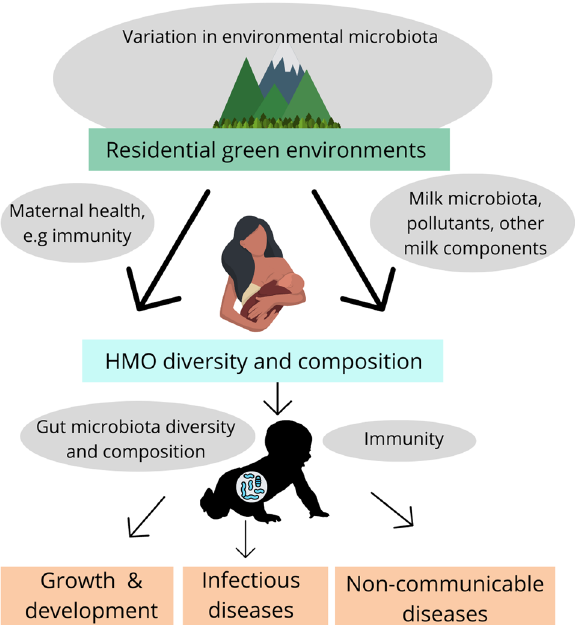
Figure 2. Potential pathways from residential green environment to infant health via variations in HMO composition. The investigated associations in this study are shown with bold arrows. The thin arrows show suggested pathways, grey ovals physiological mechanisms and orange boxes infant health outcomes, which need further studies. Green environments (with varying levels of environmental microbiota) 35,44 may influence the abundance and composition of microbiota that colonize the maternal skin and respiratory tract leading to changes in maternal immunity 26–28,32,34 and milk microbiota 42 . Green environment may also influence